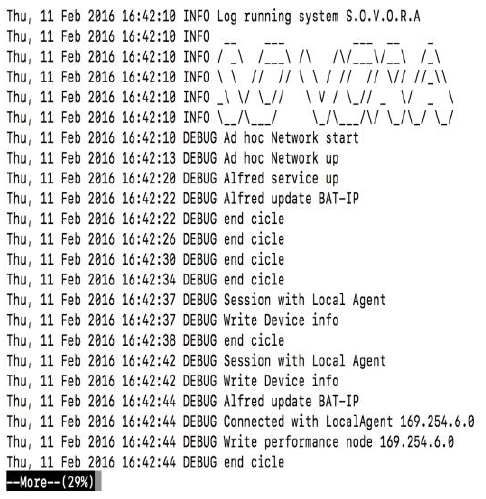
Figure 9. Local Agent Log.